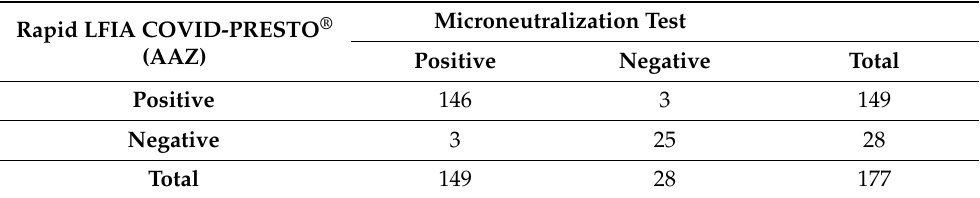
Table 1. Determination of the concordance of rapid LFIA for the detection of anti-SARS-CoV-2 IgG antibodies to microneutralization assay for the detection of neutralizing antibodies. Rapid LFIA COVID-PRESTO ®